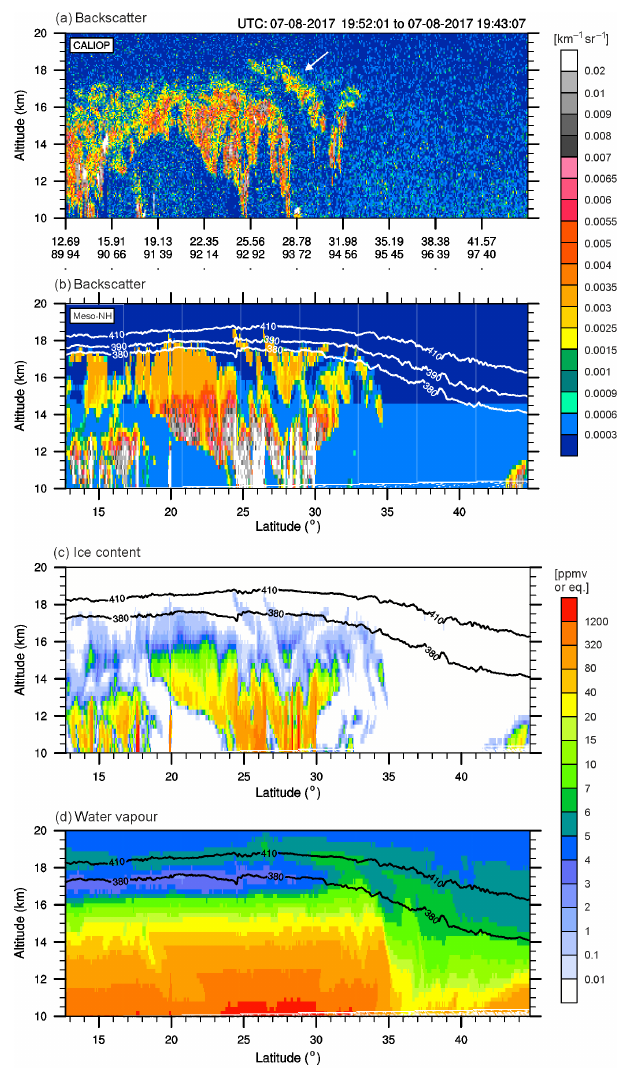
Figure 3. Backscatters at 532nm (a) measured by CALIOP at around 20:00UTC and (b) retrieved by the Meso-NH simula- tion, and (c) ice content (eq.ppmv) and (d) water vapour (ppmv) produced by the Meso-NH simulation along the CALIOP track (marked by solid line in Fig. 1) at 20:00UTC on 7 August 2017.